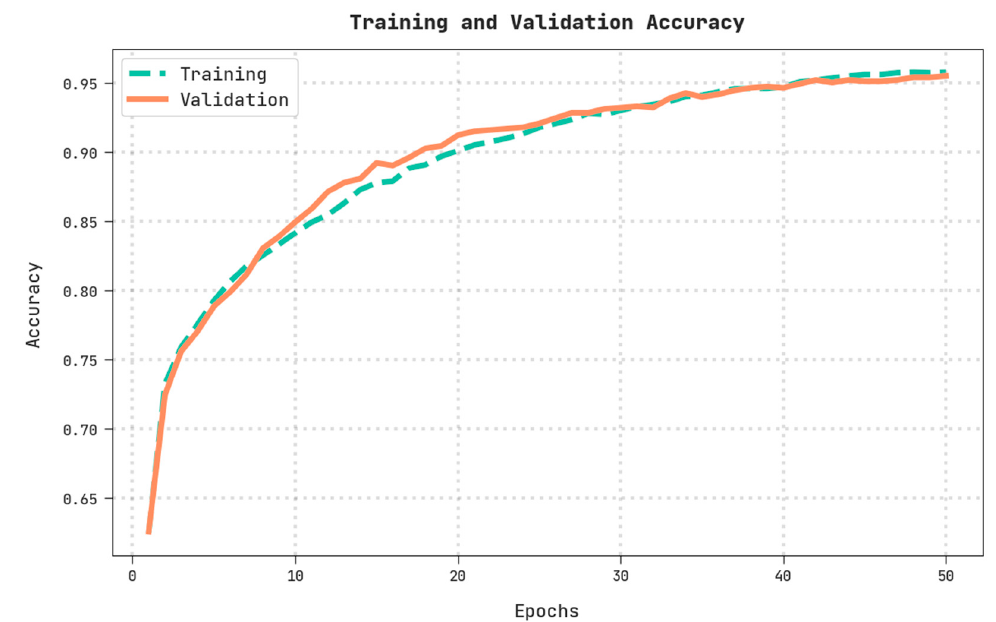
Figure 7. TRA and VLA analysis of CLBEDC-SND approach.